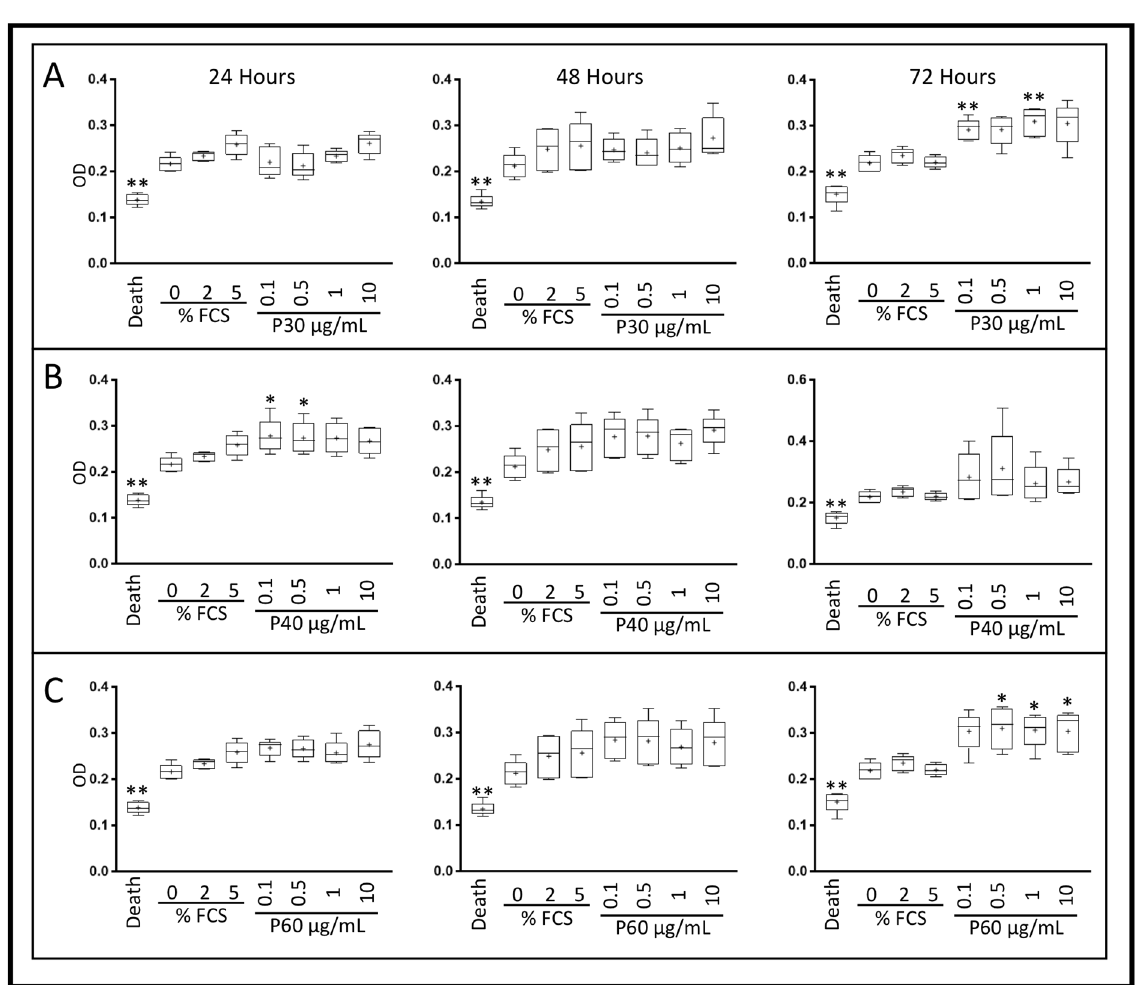
Figure 4. Effect of low concentrations of Promerim ® 30, 40, and 60 on the mitochondrial activity of equine articular chondrocytes cultured in the presence of 2% fetal calf serum (FCS). Equine articular chondrocytes were amplified and seeded at P3. At 80% of confluency, the cells were treated with Promerim ® 30 ( A ), 40 ( B ), 60 ( C ) at several concentrations (0.1, 0.5, 1, and 10 µg/mL) in the presence of 2% FCS and then cultured for 24, 48 and 72 h in hypoxia. Controls with 0%, 2% and 5% of FCS, and a death control (triton-induced death) were included. The levels of formazan were measured (OD) in the media at the end of the incubation period (XTT kit, Roche). Data are represented as box plots ( n = 5). Statistical analyses were based on the Mann–Whitney test (* p < 0.05; ** p < 0.01) and the 0% FCS condition was used as a reference. P30, P40 and P60: Promerim ® 30, Promerim ® 40, and Promerim ® 60.